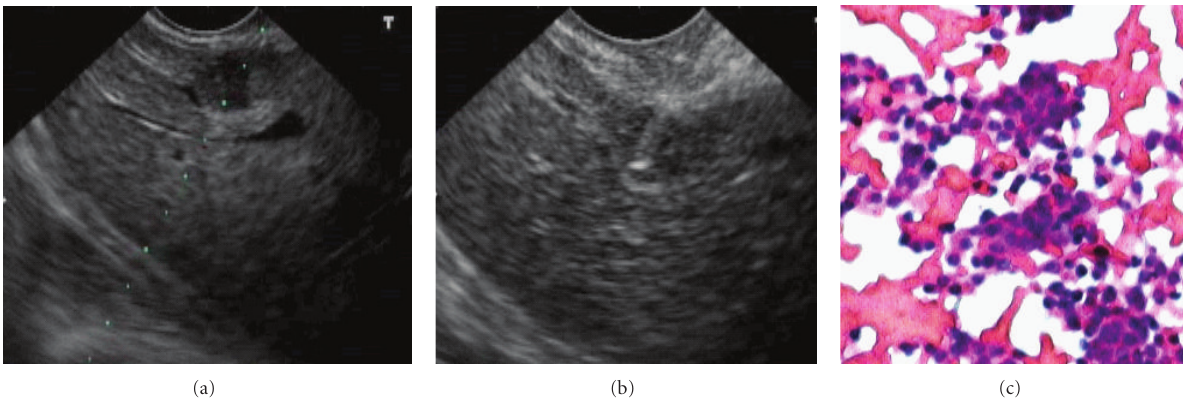
Figure 3: EUS (a), FNA (b), and cytological (c) images of the liver